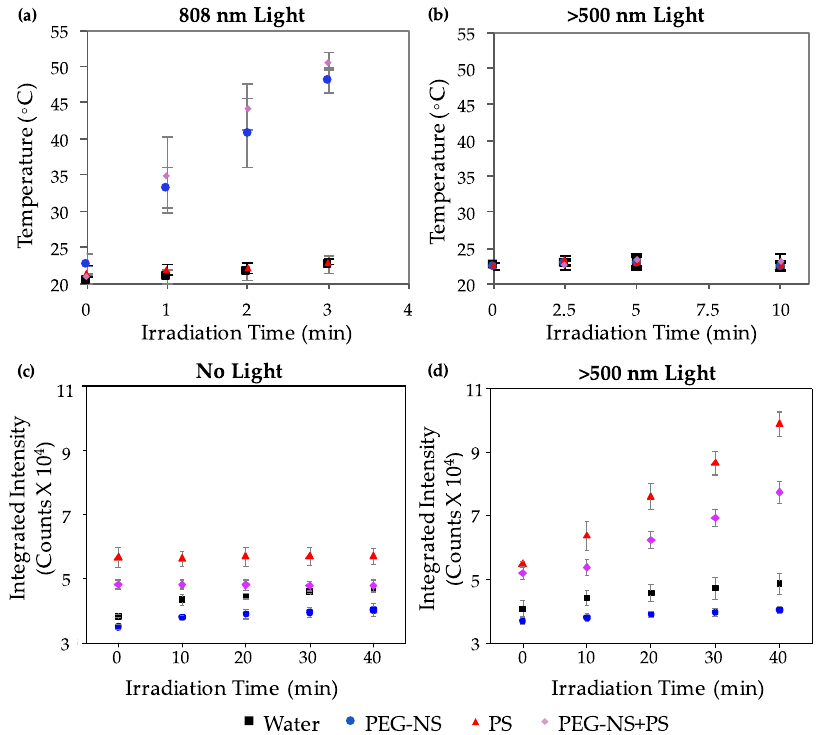
Figure 3. ( a ) Temperature measurements of water, aqueous solutions of PEG-NSs, aqueous solutions of Pd[DMBil1]-PEG 750 PSs, or aqueous solutions of both PEG-NSs + PSs during irradiation with an 808 nm continuous wave (CW) laser for 3 min or ( b ) With a λ exc > 500 nm light plate for 10 min; ( c ) Integrated intensity of fluorescence measurements from the singlet oxygen sensor green probe in solution with water, aqueous solutions of PEG-NSs, aqueous solutions of Pd[DMBil1]-PEG 750 PSs, or aqueous solutions of both PEG-NSs + PSs in the dark or ( d ) With a λ exc > 500 nm light plate for four 10 min periods of